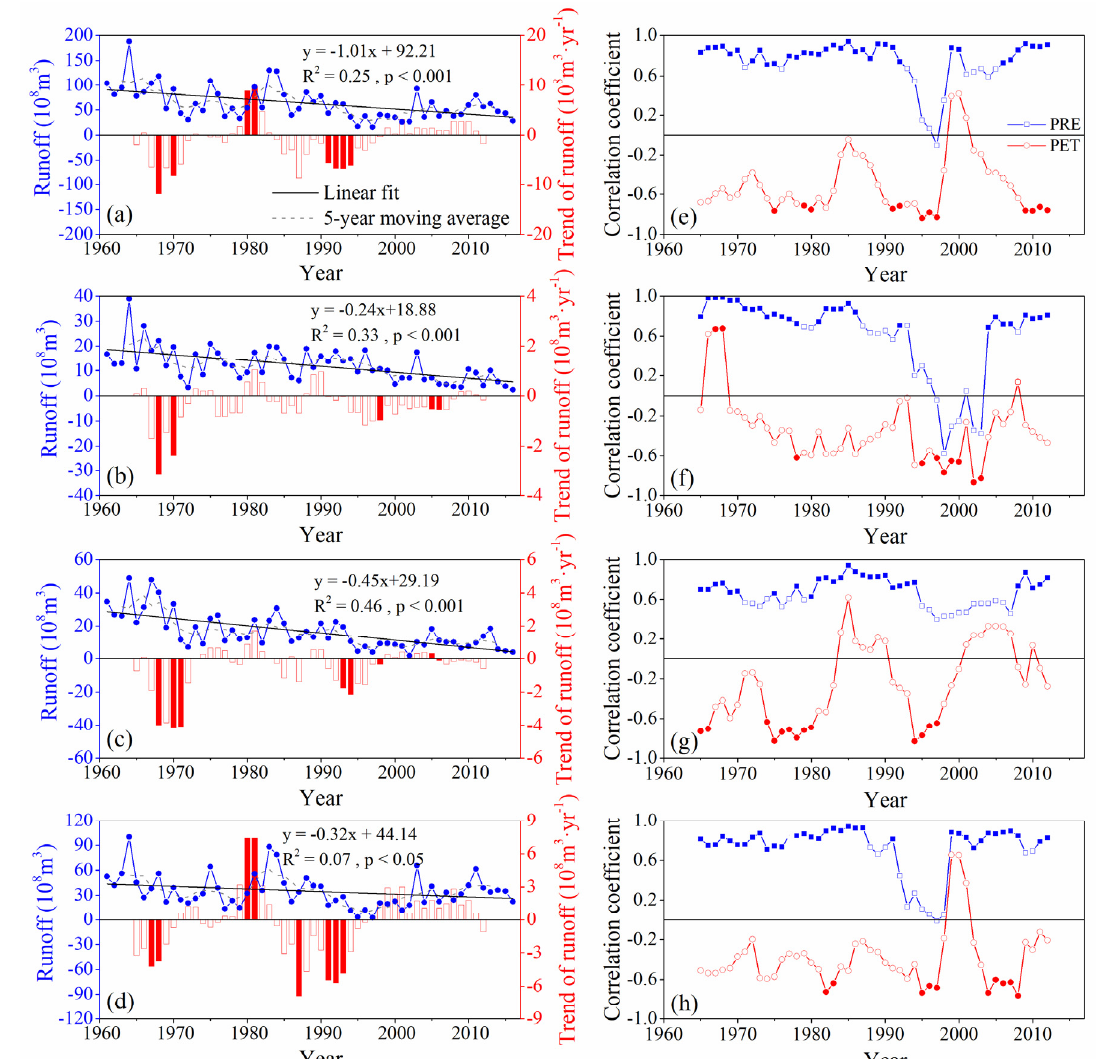
Figure 8. ( a – d ) Temporal variation of runoff and ( e – h ) partial correlation coefficient between runoff and precipitation, potential evapotranspiration during 1961–2016 over the WH, WH1, WH2, and WH3, respectively. In a-d, the blue line with dots shows the runoff series, the gray dashed line is the five-year moving average of runoff, the black line and red bar are the trend of runoff over the whole study period and a moving time window of nine years, respectively, where the solid means the runoff trend at the significance level p < 0.05 and the hollow indicates the runoff trend is not significant. The positive values of the runoff trend refer to an increase in runoff during the moving time window, while the negative values refer to a decline. In e-h, the blue line with squares and the red line with circles showed the partial correlation coefficient between runoff and precipitation, potential evapotranspiration, respectively, where the solid indicates a significant correlation and the hollow indicates no significant correlation exists.